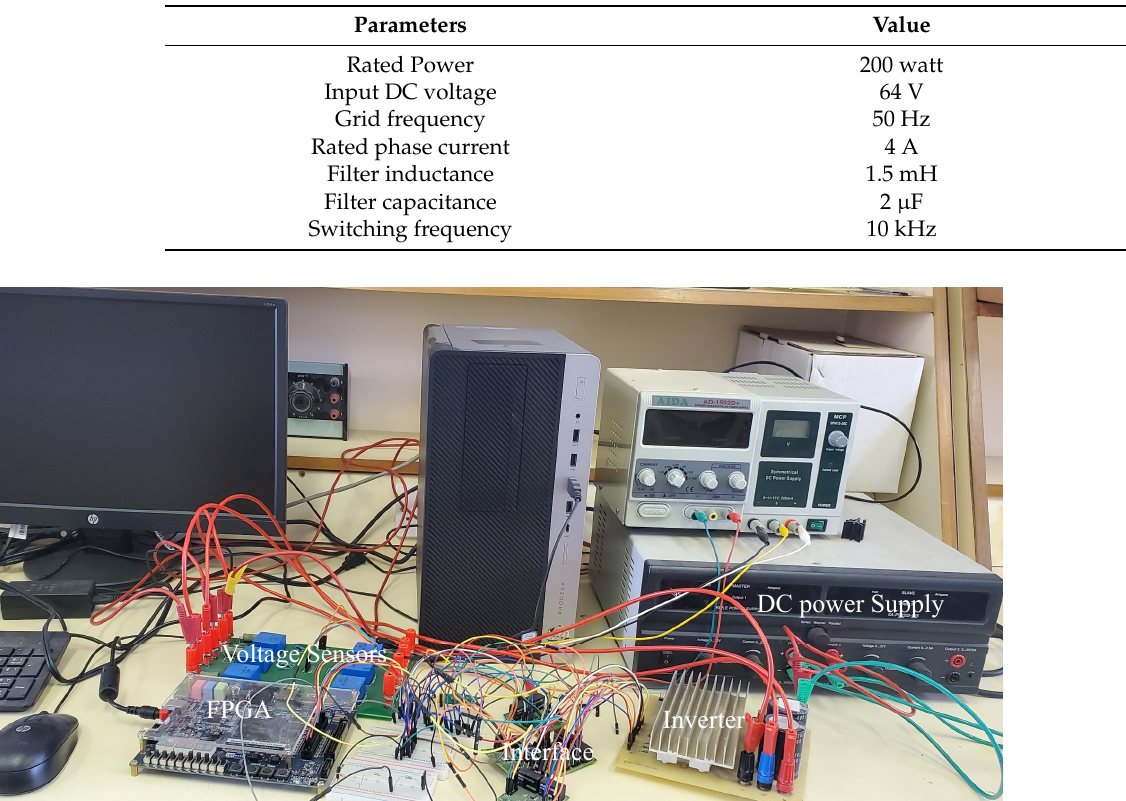
Table 2. The controller parameters.